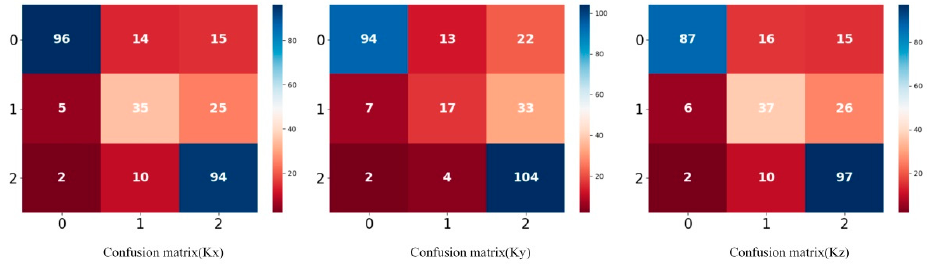
Figure 10. Confusion matrix of stiffness (MAV1) (0-high stiffness, 1-middle stiffness, 2-low stiffness).